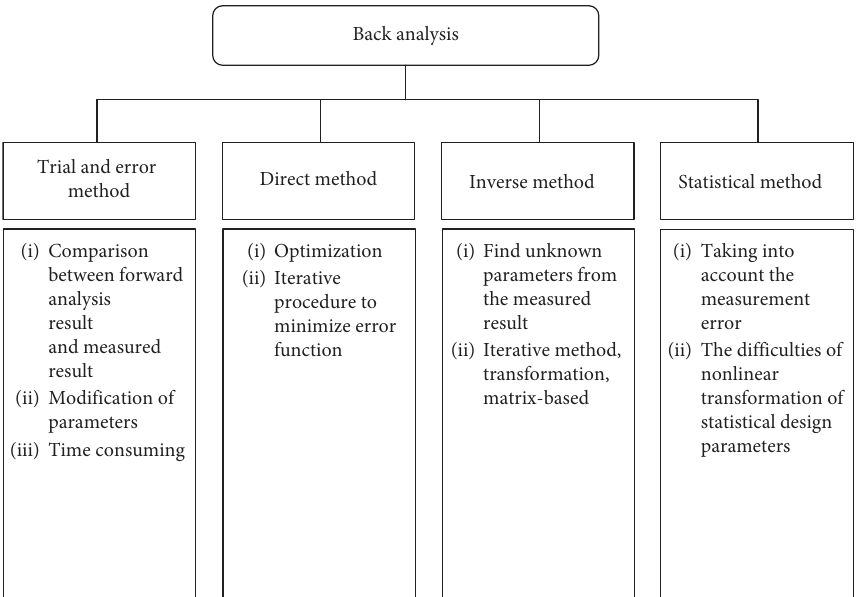
Figure 1: Classification of back analysis (An and Song